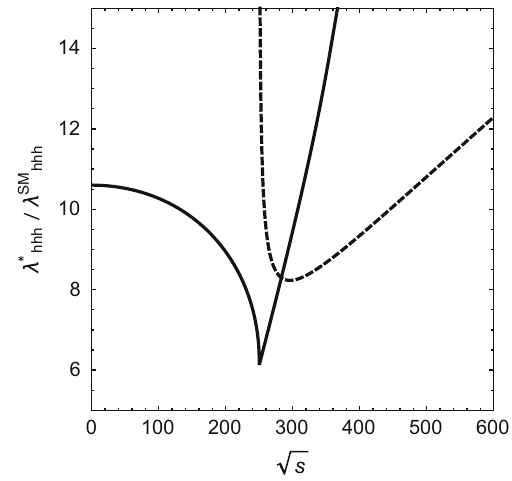
Fig. 4 Perturbativity bound λ hhh < λ ∗ from the loop-corrected √ hhh s . Full and dashed curves denote, trilinear vertex as a function of respectively, the real ( | Re ((cid:10)λ hhh )/λ hhh | < 1) and imaginary ( | Im ((cid:10)λ hhh )/λ hhh | < 1) contributions to the bound due to the ver- tex correction in Eq.